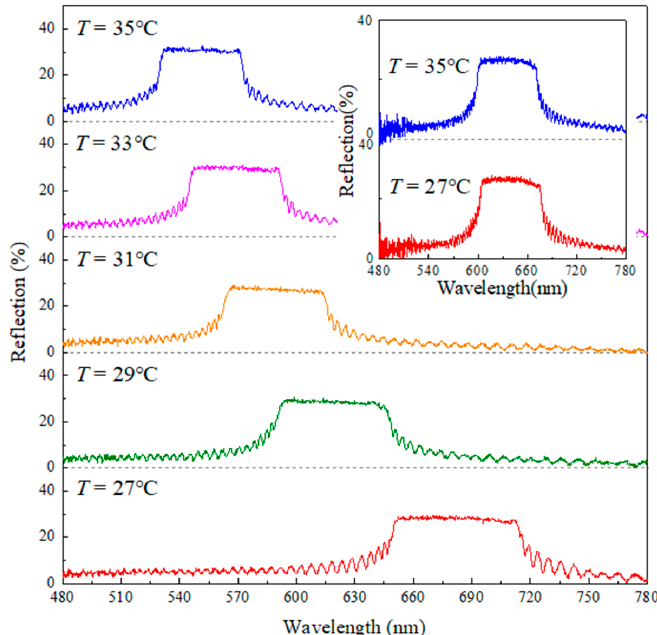
Figure 3. The reflection spectra of thermosensitive cholesteric liquid crystal (CLC) mixture II measured from 27 to 35 °C. The inset shows the thermostability of the reflection band of CLC mixture from 27 to 35 ◦ C. The inset shows the thermostability of the reflection band of CLC mixture I in the I in the temperature range studied. temperature range